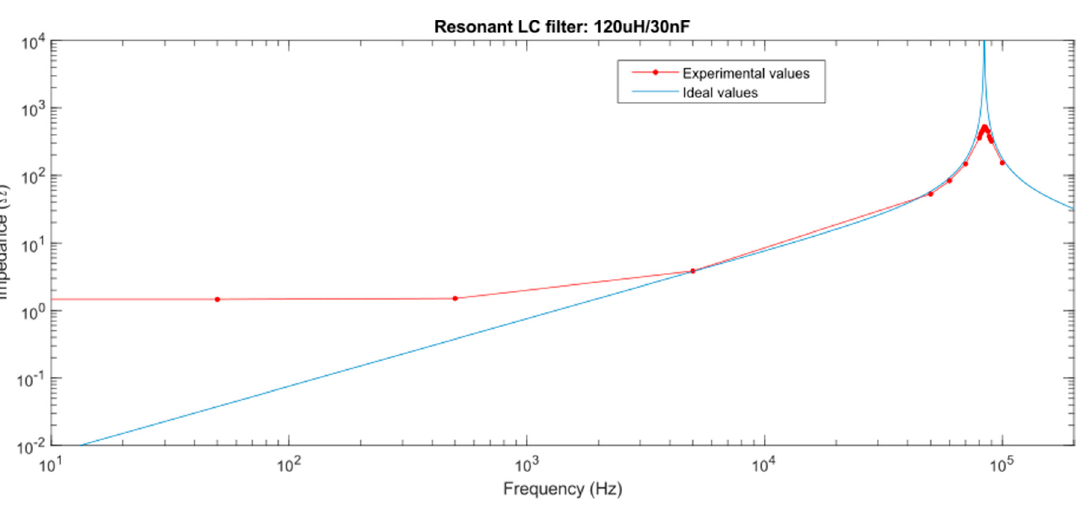
Figure 9 . Resonant filter impedance values. Figure 9. Resonant filter impedance values.